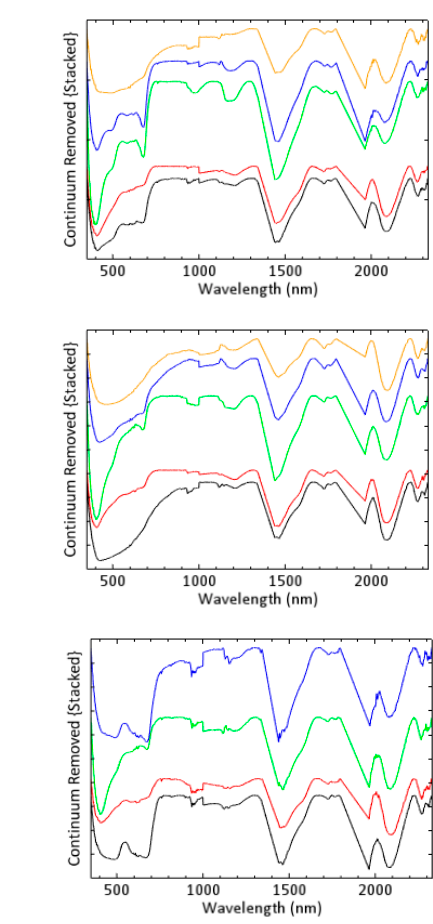
Figure 7. Select spectral samples over time of the five grass species. ( a ) Reflectance, ( b ) continuum removed (CR) offset for clarity. BF01 D. milanjiana (Jarra grass), BF02 and BF03: B. humidicola (Tully grass), BF04: D. milanjiana (Arnhem grass), and BF05: D. eriantha (Pangola grass). See the S3 for the full dataset.